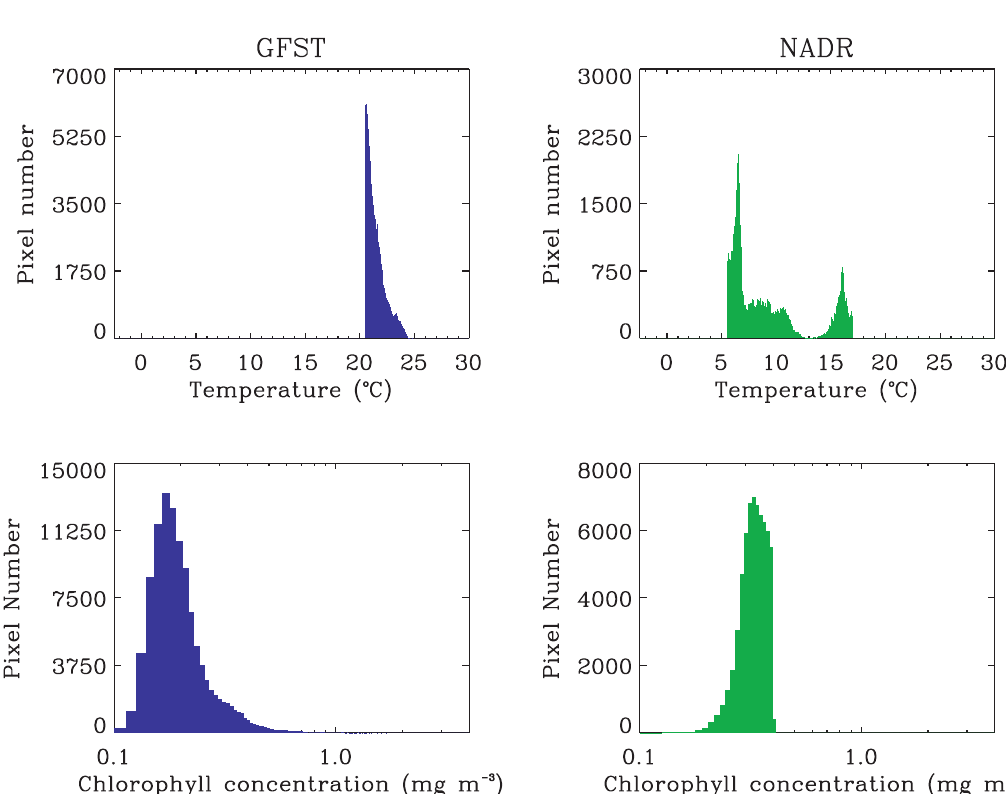
Fig. 9. – Frequency distribution of sea surface temperatures and chlorophyll concentrations for the spring season extracted from the composite image after application of criteria to determine the provinces dynamic